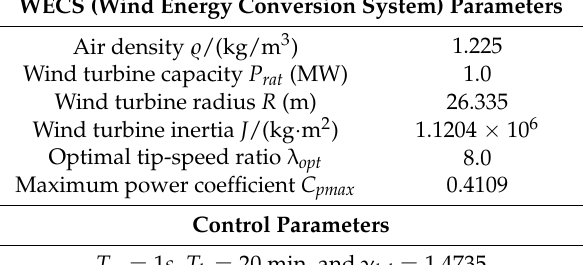
Table 3. Simulation